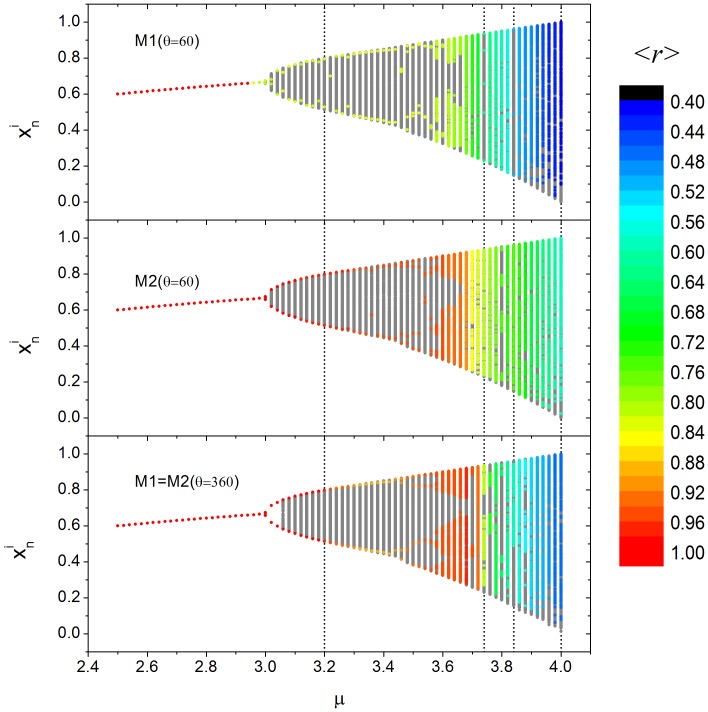
(Color online) Bifurcation diagram for M1 and M2 considering ρ = 0.4 and D = 0.5.Gray dots show all possible claw displacement values assumed by all individuals. Colored dots show one possible claw asymptotic displacement values (assumed by one individual) for 800<n<1000. Colored scale refers to the global correlation value, <r>. For µ<3 both models predict a stable fix point (gray dots are behind to colored dots). Vertical black dot lines highlight the cases where µ = {3.2, 3.74, 3.84, 4}. The first and the last values are the ones set in Figs. 5 and 7. The other two values have, respectively, five and three period orbits only for M1 model (as predict by uncoupling logistic map).